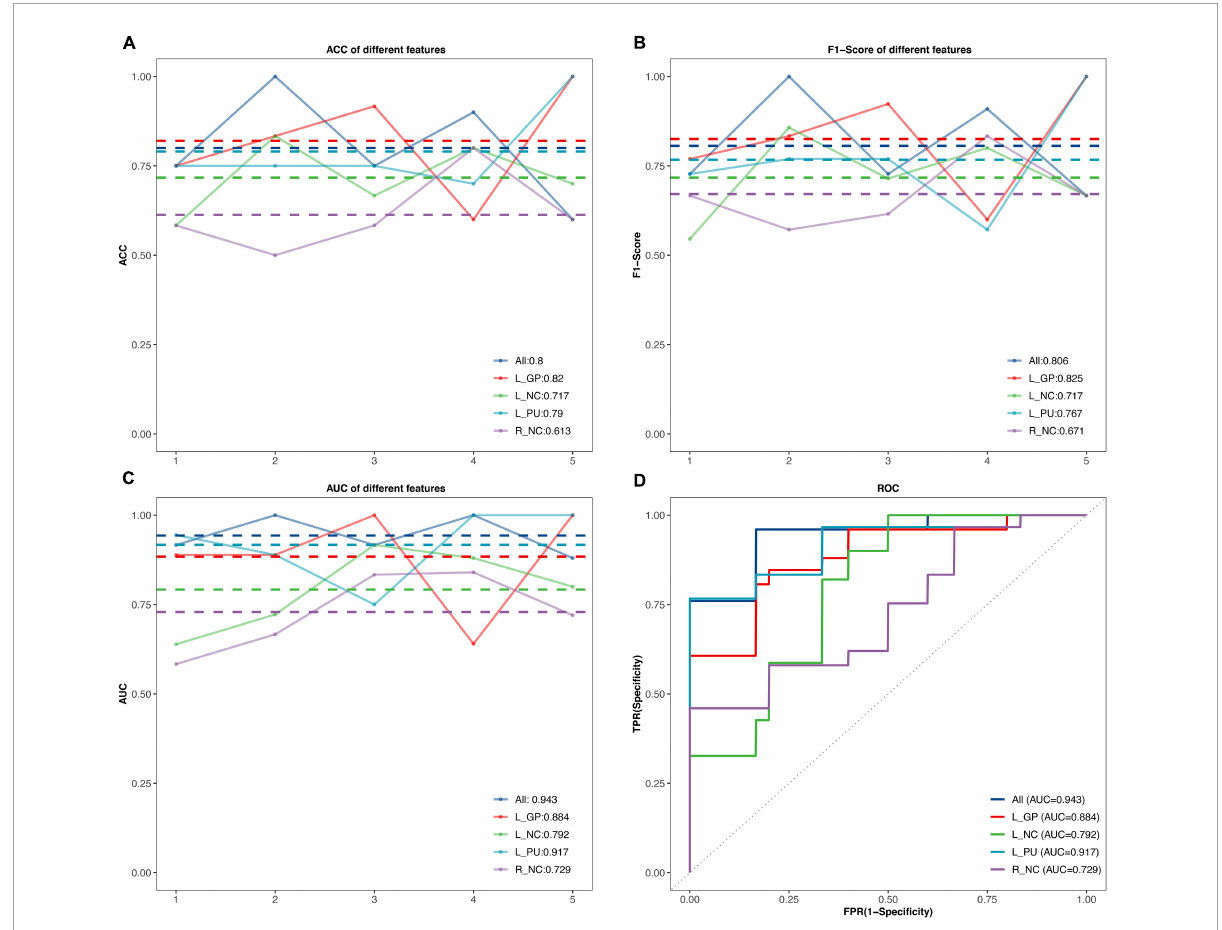
FIGURE3 The classification performance of the SVM model. (A–C) The accuracy, F1-Score, and the area under curves (AUC) values in the testing set for different features. The horizontal axis represents five outer resampling, the vertical axis represents the values of measurement. The mean value of each measurement is marked with the dotted line of the same color as the broken line. (D) The receiver operating characteristic (ROC) curves. ACC, accuracy; AUC, area under the curve; R, right; L, left; NC, Caudate nucleus; PU, putamen; GP, Globus